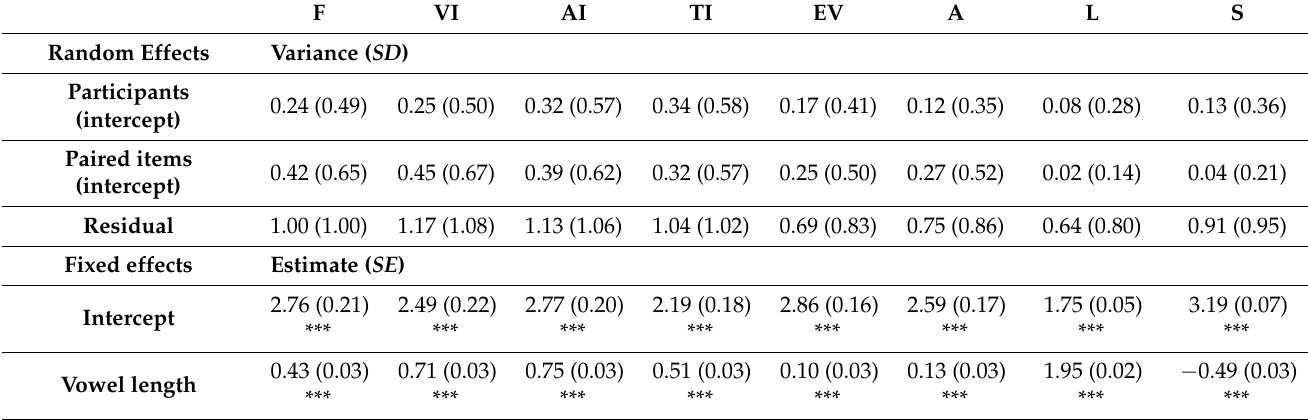
Table 2. Results of mixed-effects models for paired list of written Japanese sound-symbolic words including long vowels (LV) and short vowels